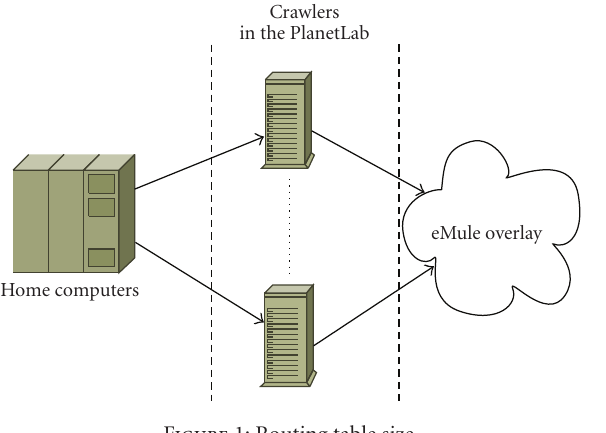
Figure 1: Routing table size.